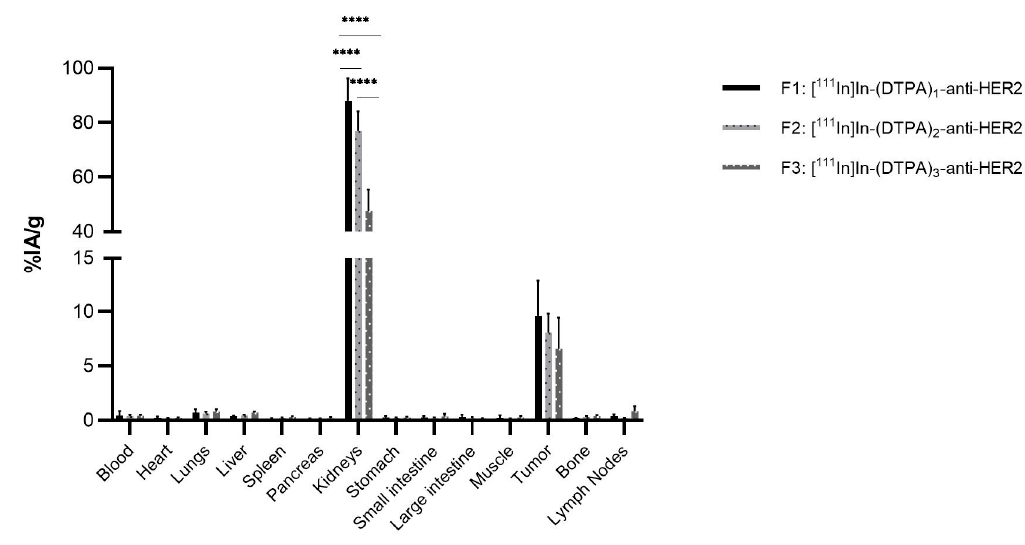
Figure 4. Ex vivo biodistribution analysis of [ 111 In]In-(DTPA) n -anti-HER2 fractions in athymic nude mice ( n = 6 per group), with a human HER2 expressing SKOV-3 tumor (**** p < 0.001).